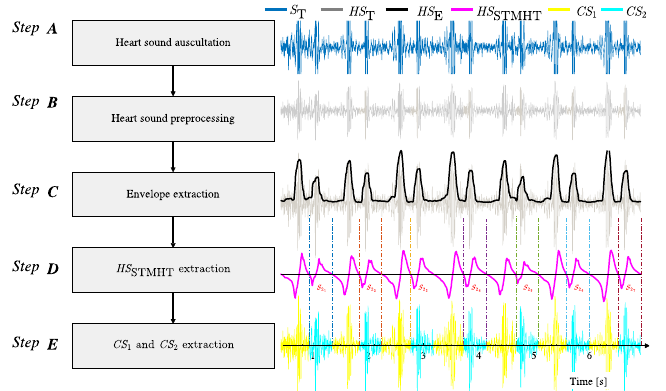
Figure 2. Flow chart of the CS 1 and CS 2